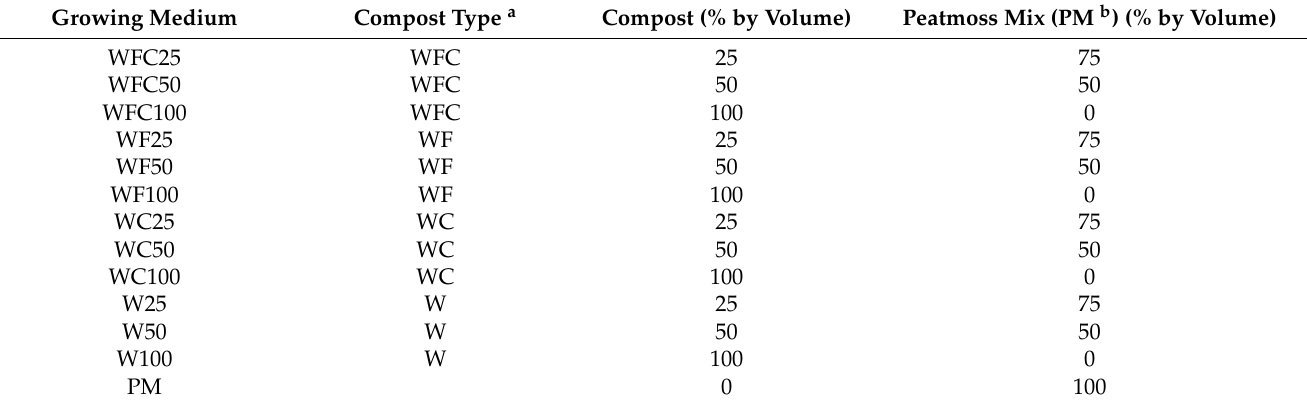
Table 1. Proportion of compost and commercial peatmoss mix for growing